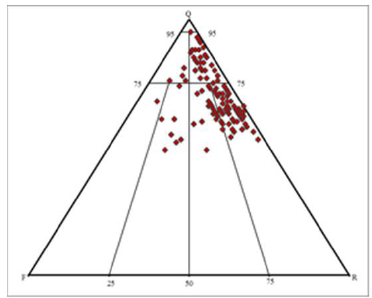
Figure 2. Ternary diagram based on Folk (1968) illustrating the composition of the Xu2 sandstones. Q-detrital quartz grains, F-detrital feldspar grains, R-rock fragments.